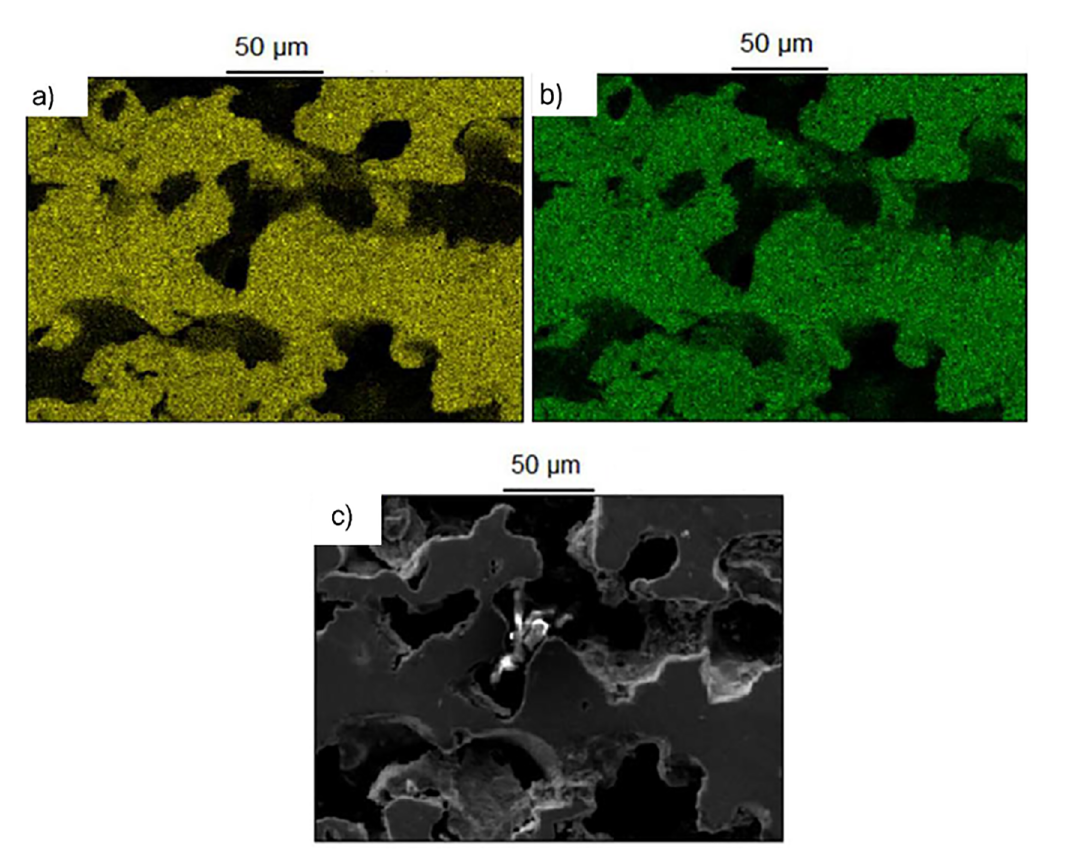
Figure 6. Results of elemental dot mapping (Ti (a) and Ni (b)) on samples processed under condition 5 (c)